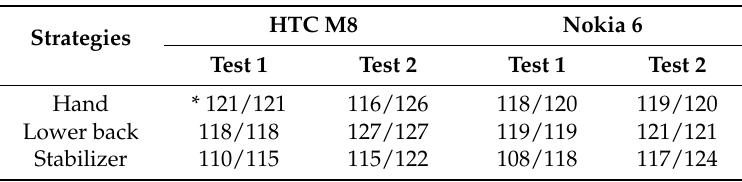
Table 3. Test results of step-detection